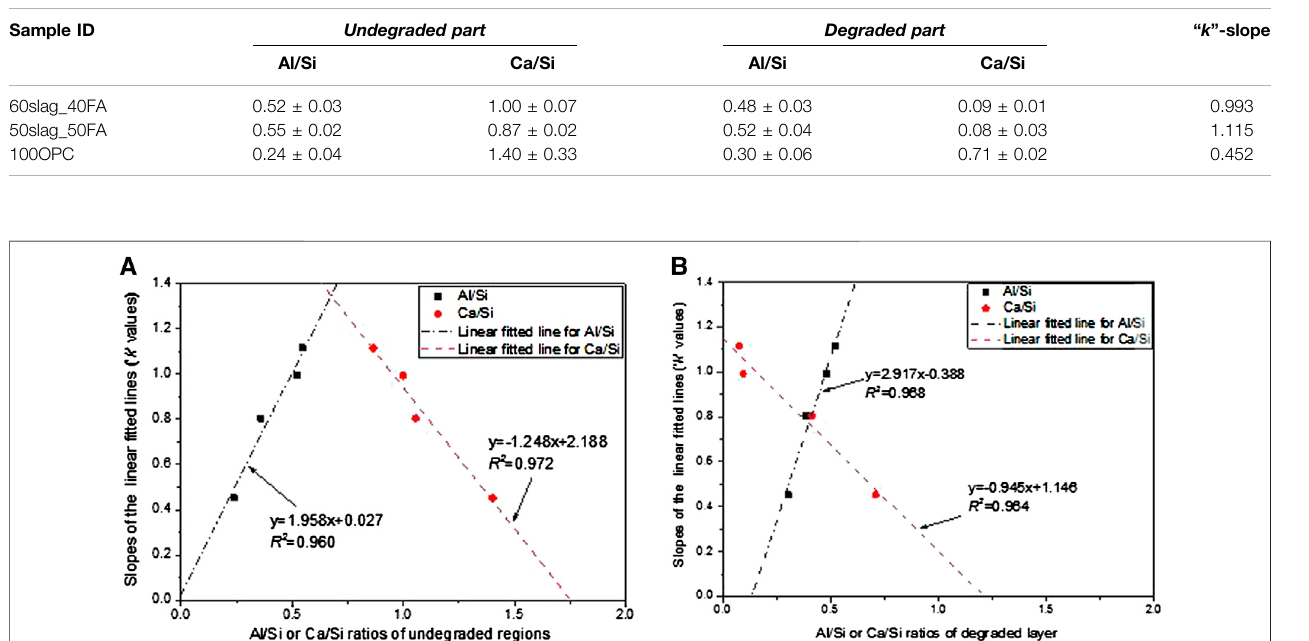
Frontiers in Materials |